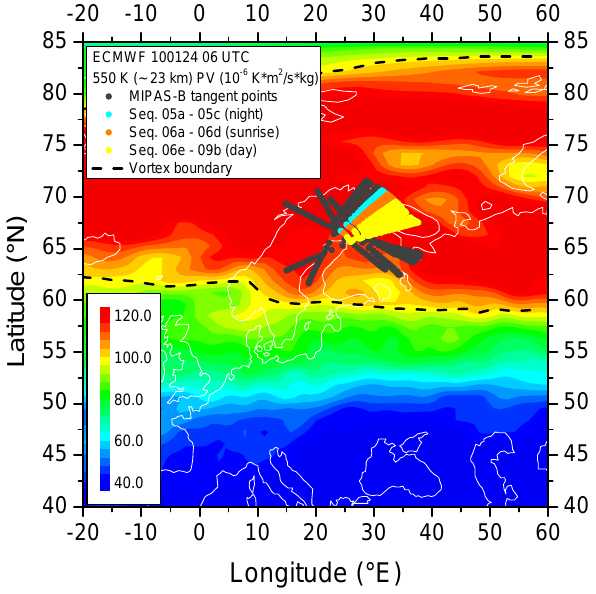
Fig. 1. Potential vorticity (PV) field from European Centre for Medium-Range Weather Forecasts (ECMWF) analysis on 24 January 2010, 06 UTC. MIPAS-B tangent points are plotted as solid circles. Sequences observed during night, close to sunrise, and during day are marked with different colours. The vortex boundary which represents the strongest PV gradient (Nash et al., 1996) is shown as dashed line.